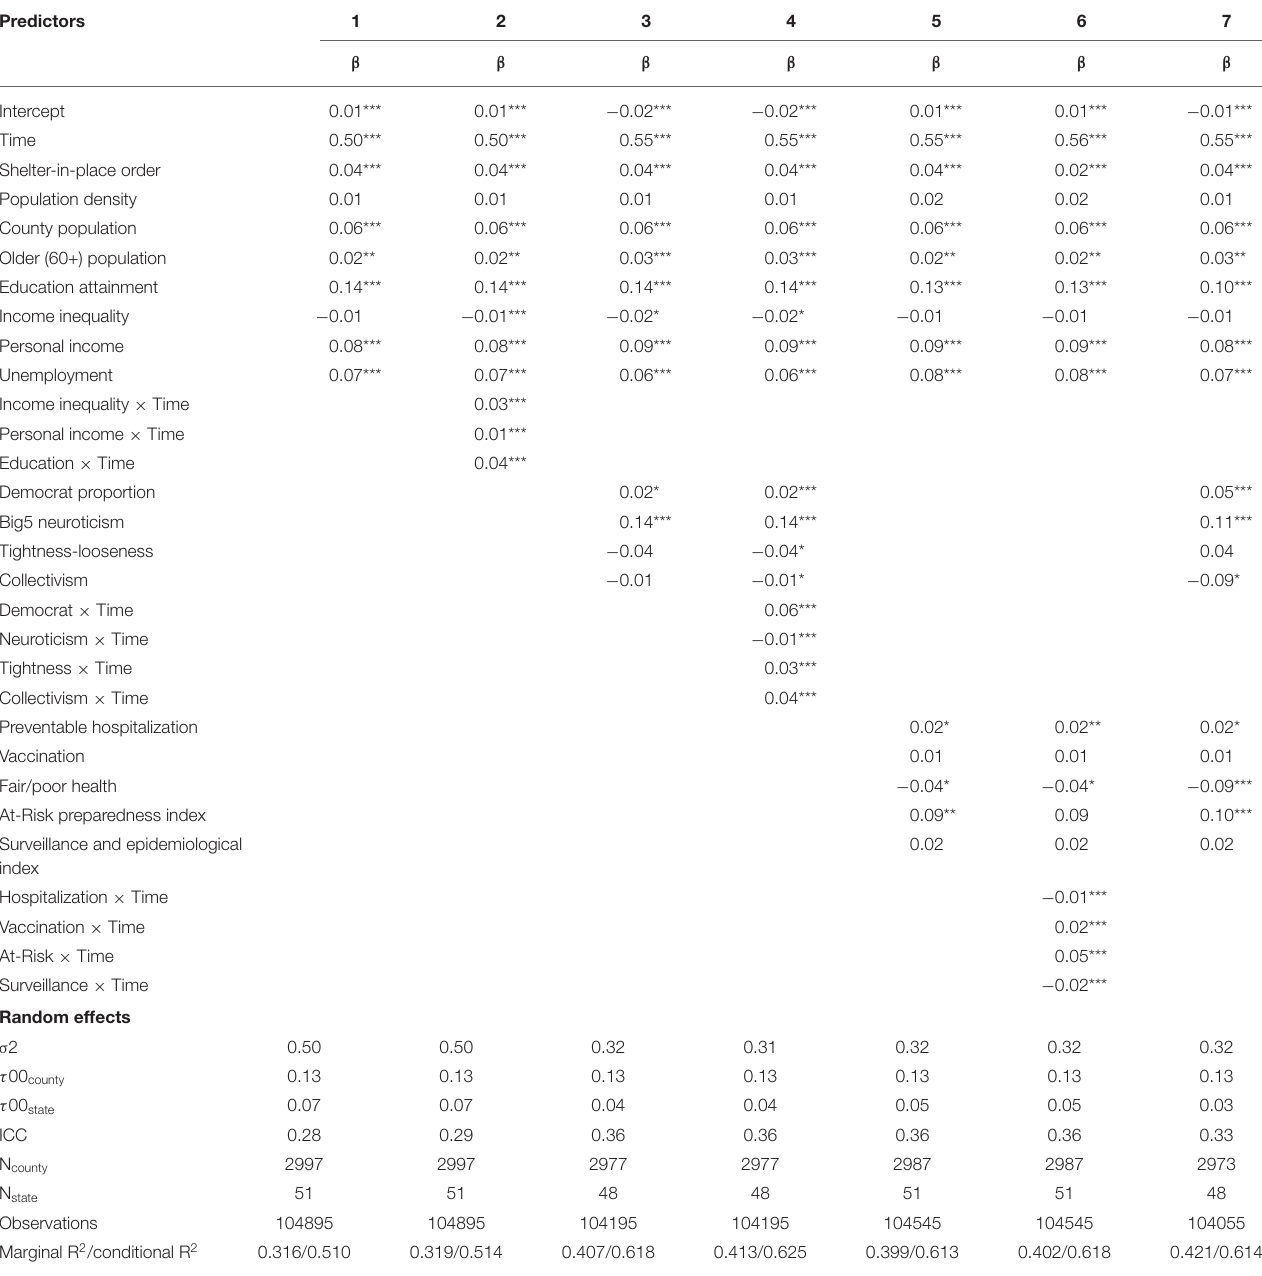
TABLE 2 | Reduction in distance mobility (From March 8 to April 12, 2020).